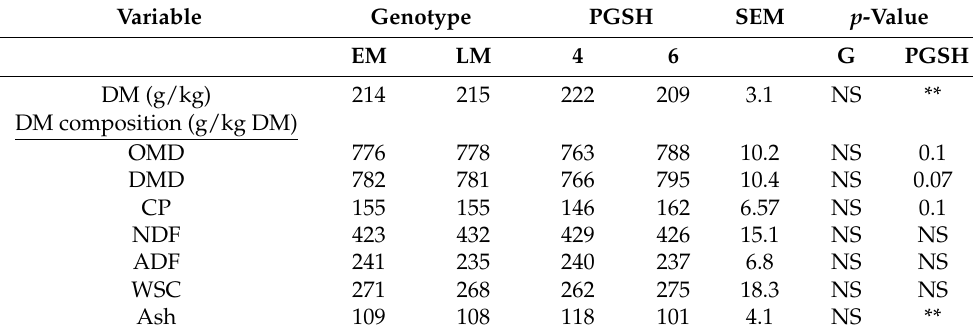
Table 2. Effect of genotype (G-early- (EM) or late-maturing (LM)) and post-grazing sward height (PGSH-4 or 6 cm) on herbage chemical composition and in vitro digestibility during the grazing season.